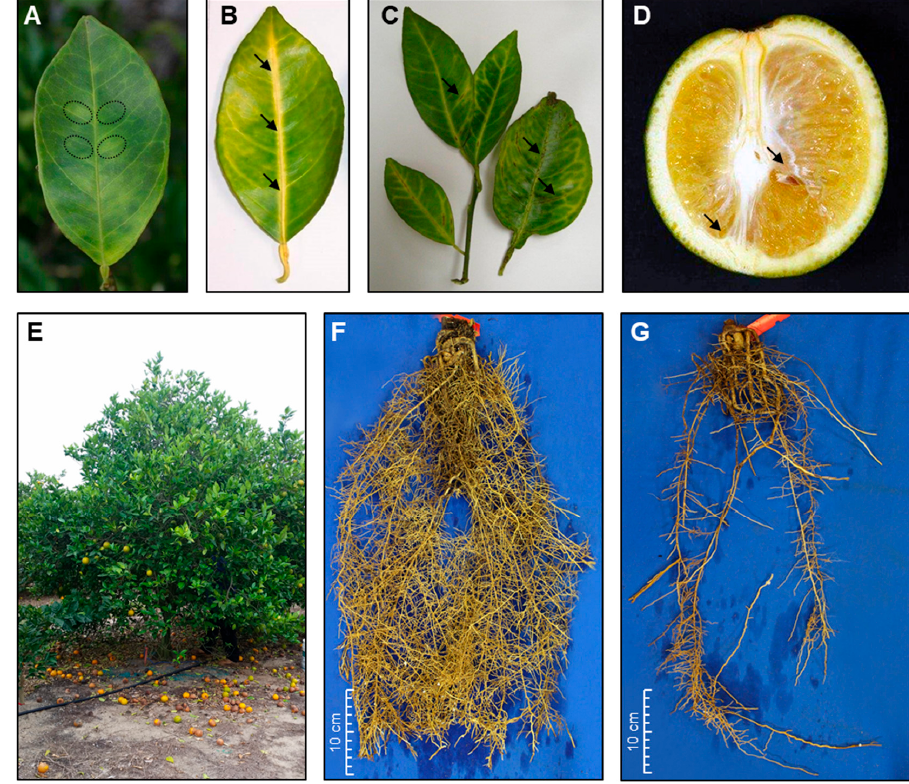
Figure 1. The characteristic symptoms of huanglongbing (HLB) disease. ( A ) Blotchy mottle symptom on HLB-positive citrus leaves with asymmetric patterns of discolorations around the leaf midvein; ( B ) Yellow vein symptom on HLB-positive citrus leaves; ( C ) Leathery leaves with enlarged corky veins from HLB-affected trees; ( D ) Lopsided, asymmetric, and small-sized fruits from HLB-affected trees; ( E ) HLB-induced preharvest fruit drop; ( F , G ) The root system of HLB-free (healthy) and HLB-positive trees, respectively. Photos used in panels ( A – D ) were provided by Dr. Pedro C. Gonzalez-Blanco whereas the photo used in panel ( E ) was provided by Dr. Tripti Vashisth, Department of